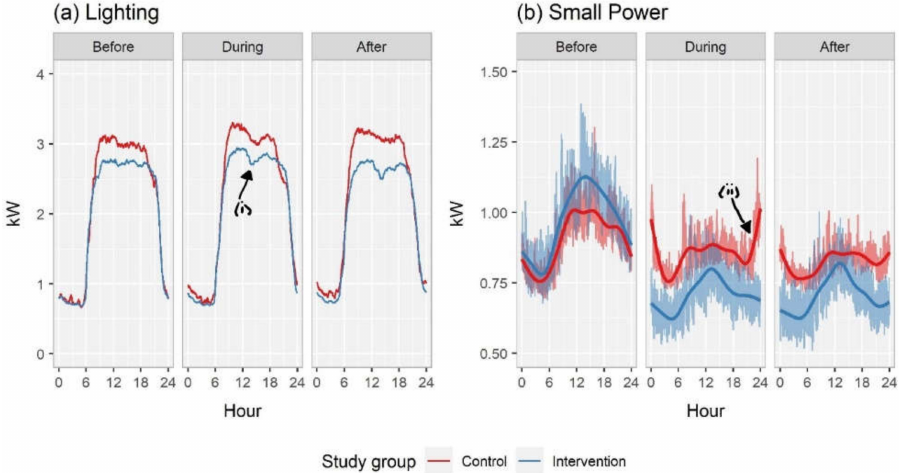
Figure 4. Average daily electricity profile for ( a ) lighting and ( b ) small power, comparing the control (RED) and intervention (BLUE) study groups for the study periods before (1 September– 31 October 2017), during (1 November 2017–31 January 2018) and after (1 February–30 April 2018) the behavior change intervention. Data shown as the average power for each minute of the day over the 3 month period.